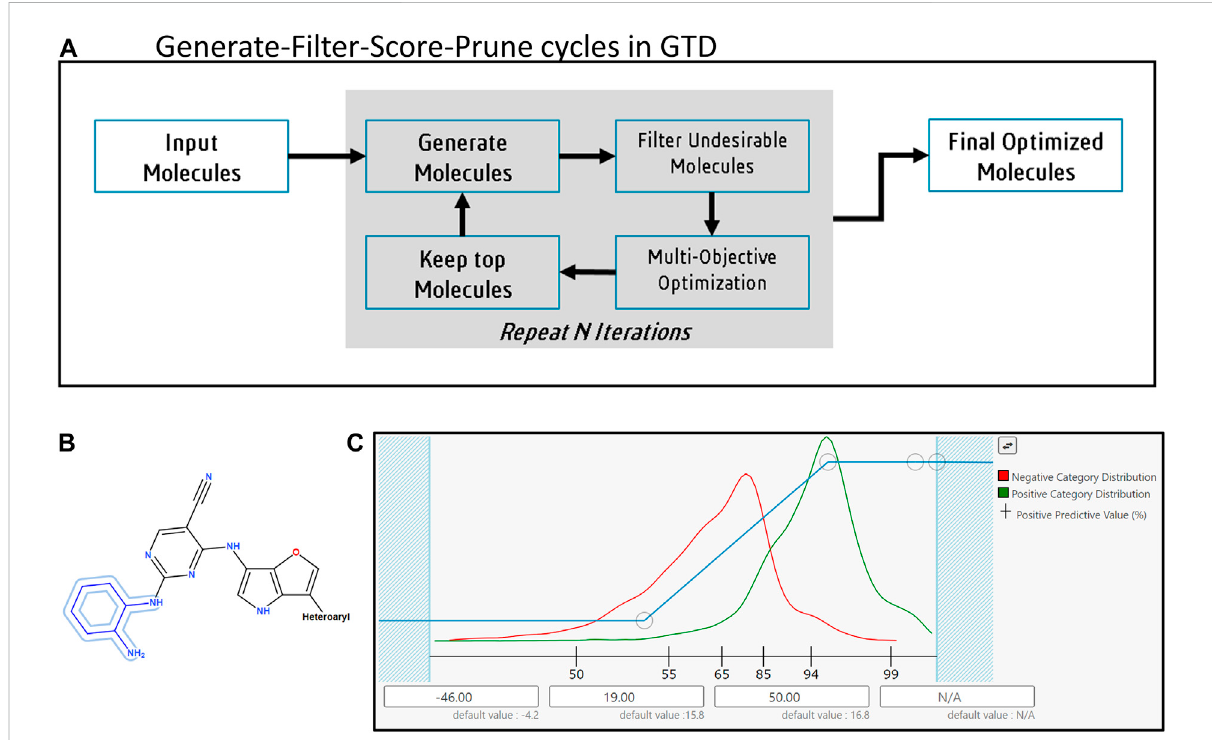
FIGURE 1 The Generative Therapeutics Design platform. (A) The generate- fi lter-score-prune cycle. (B) Example for Input molecule with fi xed atoms and homology groups (Fixed atoms, outlined in blue, are not modi fi ed during the molecule generation process; homology groups, like “ heteroaryl ” or “ heterocyclic ” imposerestrictionsonthesubstituentsacceptedatspeci fi cpositionsonacore). (C) Userinterfacetosetupadesirability functionfora predictive model in GTD. Red line shows histogram of scores for training samples labeled as “ bad ” when the model was created, green line shows histogram ofsampleslabeled “ good ” . Histograms help userre fi neGTDsuggested desirabilitymapping function. Circular markers on blue line are user con fi gurable in fl ection points controlling the mapping of a raw score for a candidate molecule (along X-axis) to a desirability value (Y-axis). X-axis labels show Positive Predictive Value for the predictive model. When no training data results are available GTD generates a histogram of predicted responses from a selection of FDA approved